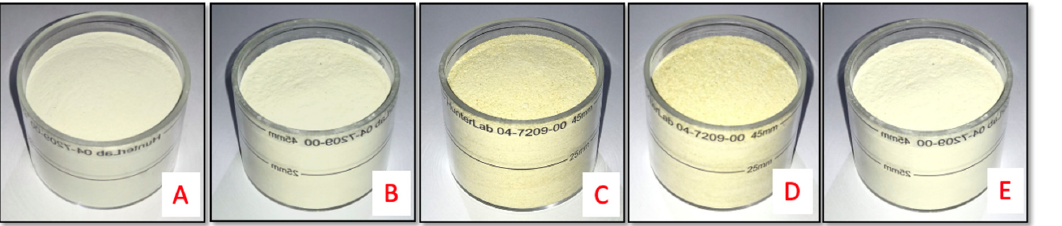
Figure 2. Potato flour prepared from different pretreatments and drying methods. ( A ) Oven drying; ( B ) blanching at low temperature (60 °C); ( C ) blanching at high temperature (95 °C); ( D ) boiling; ( E ) freeze drying.